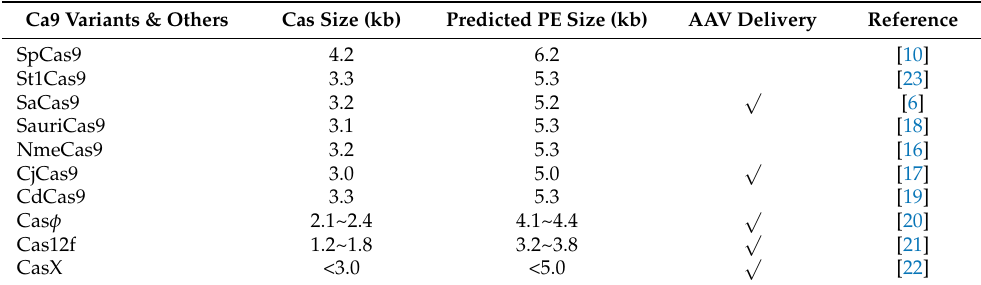
Table 2. Prediction of PE size with various Cas